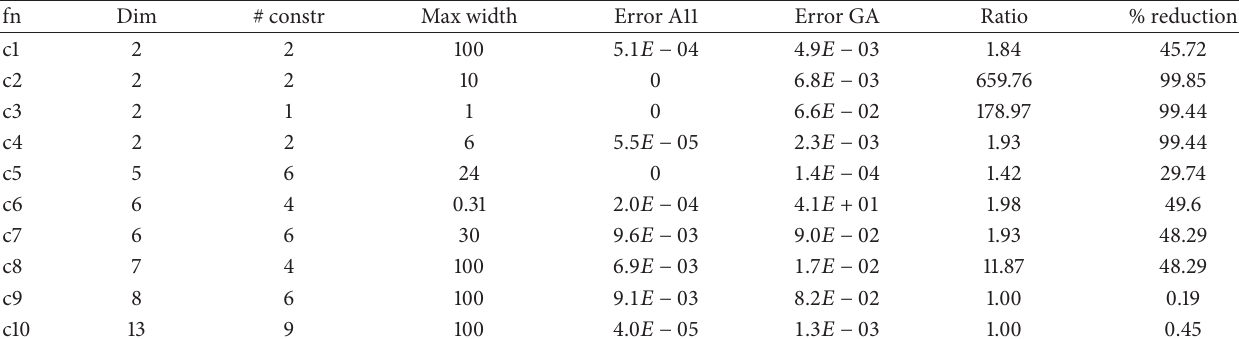
Table 10: The result of constrained problems. The ratio in the seventh column is the ratio of number of functions evaluations used by GA to the number used by A11. The last column is the percentage of the number of function evaluations that can be reduced when using A11. fn Dim # constr Max width Error